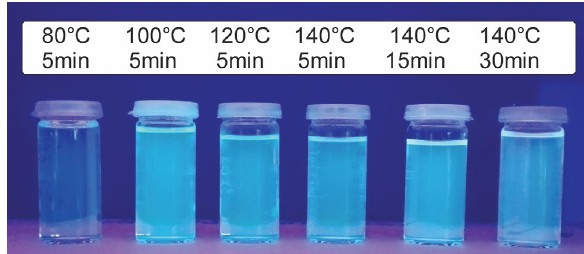
Figure 3. Solutions after preparation under illumination with a UV lamp. The process temperature and process duration is indicated for each